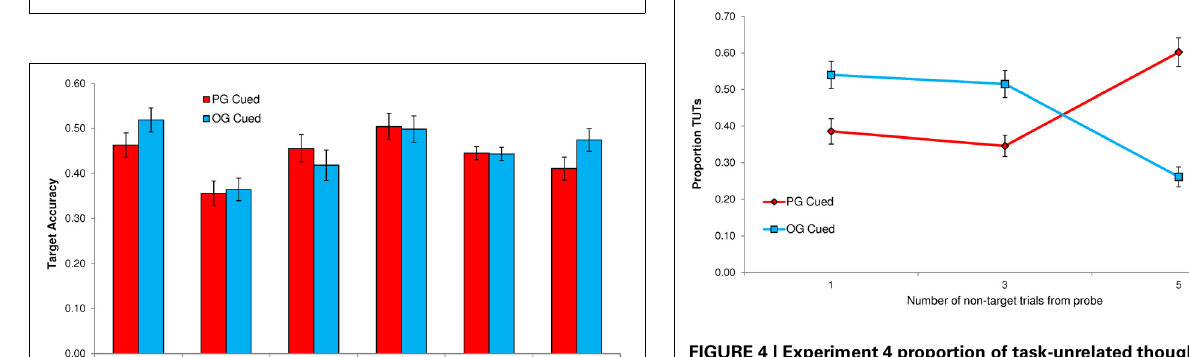
FIGURE 4 | Experiment 4 proportion of task-unrelated thoughts (TUTs) in the Sustained Attention to Response Task following personal-goal (PG) cues and other-goal (OG) cues, presented either 1, 3, or 5 non-target trials preceding the target and thought probe. CI [0.025, 0.094], reflected a moderate effect size ( d = 0 . 457)